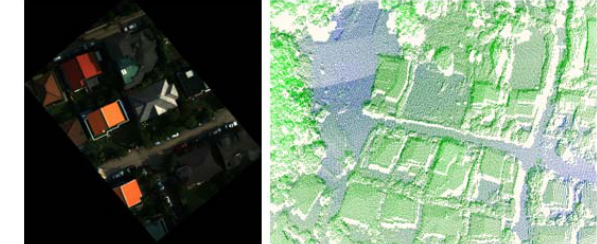
Figure 7. Ortho-rectified photos (left) and aerial LiDAR by RAMS (right) Before terrestrial LiDAR scanning, Ground Control Points (GCPs) survey was carried out using static GPS method as setting up eight control points around the landslide and the reservoir’s bank collapse area for almost eight hours. The data process of collected LiDAR point clouds was performed as following; point cloud geo-referencing and registration, outlier eliminating, 3D mesh/surface generating and editing, DTM generating, and 3D modelling of the study